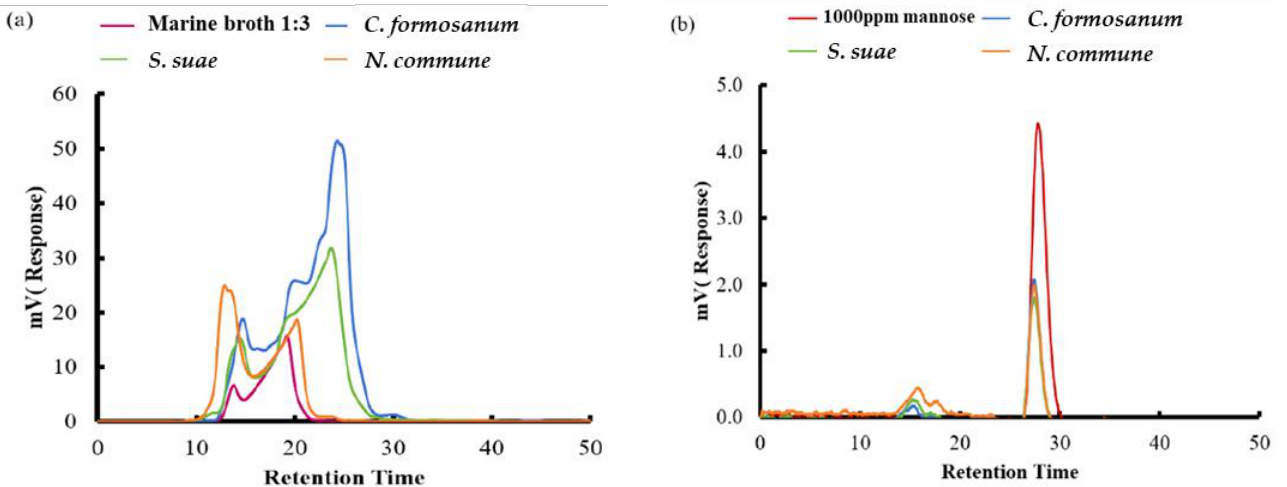
Figure 11. The mannose variation of Colaconema formosanum , Sarcodia suae , and Nostoc commune assayed by HPLC analysis ( a ) before fermentation and ( b ) after fermentation. Fermented C. for- mosanum , S. suae , and N. commune were diluted 100 times with deionized water before passing the HPLC column.